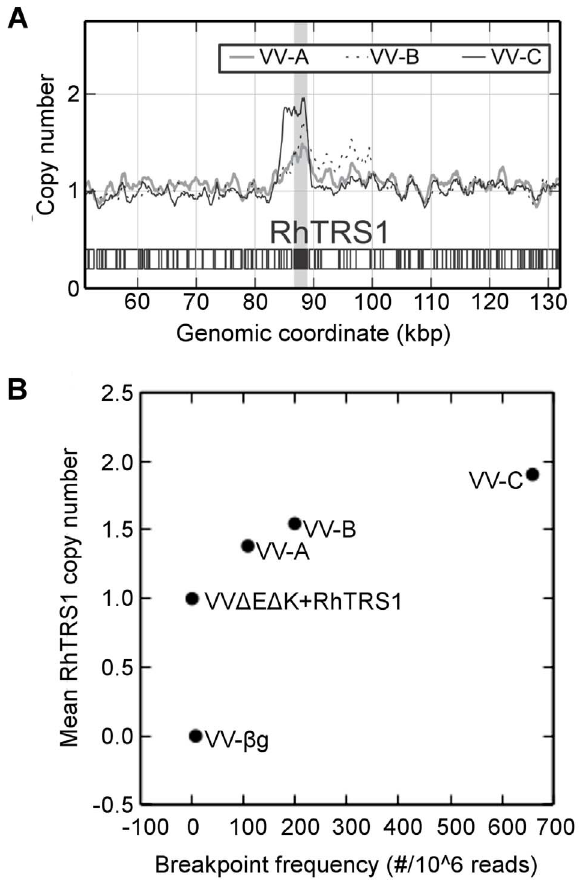
Figure 4. Rhtrs1 copy number variation relative to VV D E D K + RhTRS1. (A) Relative read depth of Illumina sequencing reads in the passaged virus pools normalized to VV D E D K + RhTRS1. The graph is centered on the rhtrs1 locus (grey bar). (B) Copy number of RhTRS1 (rescaled so that parental strain=1) plotted against breakpoint read frequency (per million mapped reads) demonstrates agreement between each independent measure of RhTRS1 duplication.